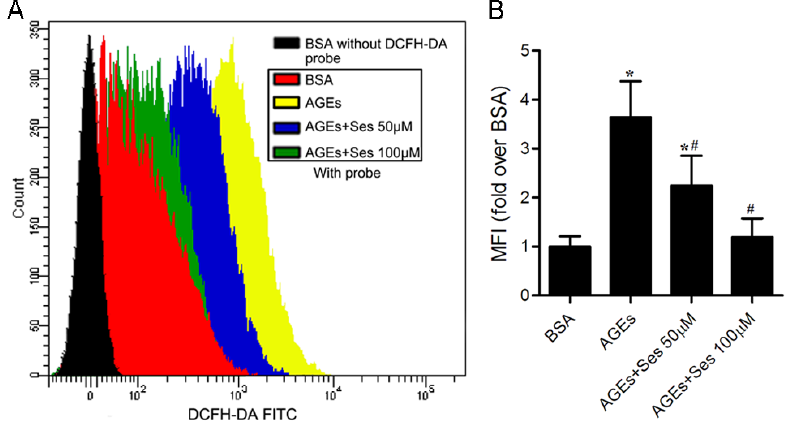
Figure 7. Effects of sesamin on ROS (peroxides) production in MIN6 cells. Cells were prepared as in Figure 5. ( A ) Representative pictures of ROS generation measured by flow ROS accumulation in MIN6 cells. Values are expressed as mean ± SD, n = 4. * p < 0.05 versus BSA. # p < 0.05 versus AGEs. MFI: Mean fluorescence